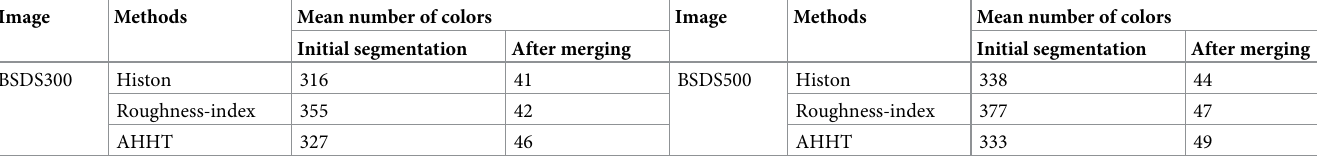
Table 2. Comparison between the mean number of colors in the initial segmented result and the result after merging. Image